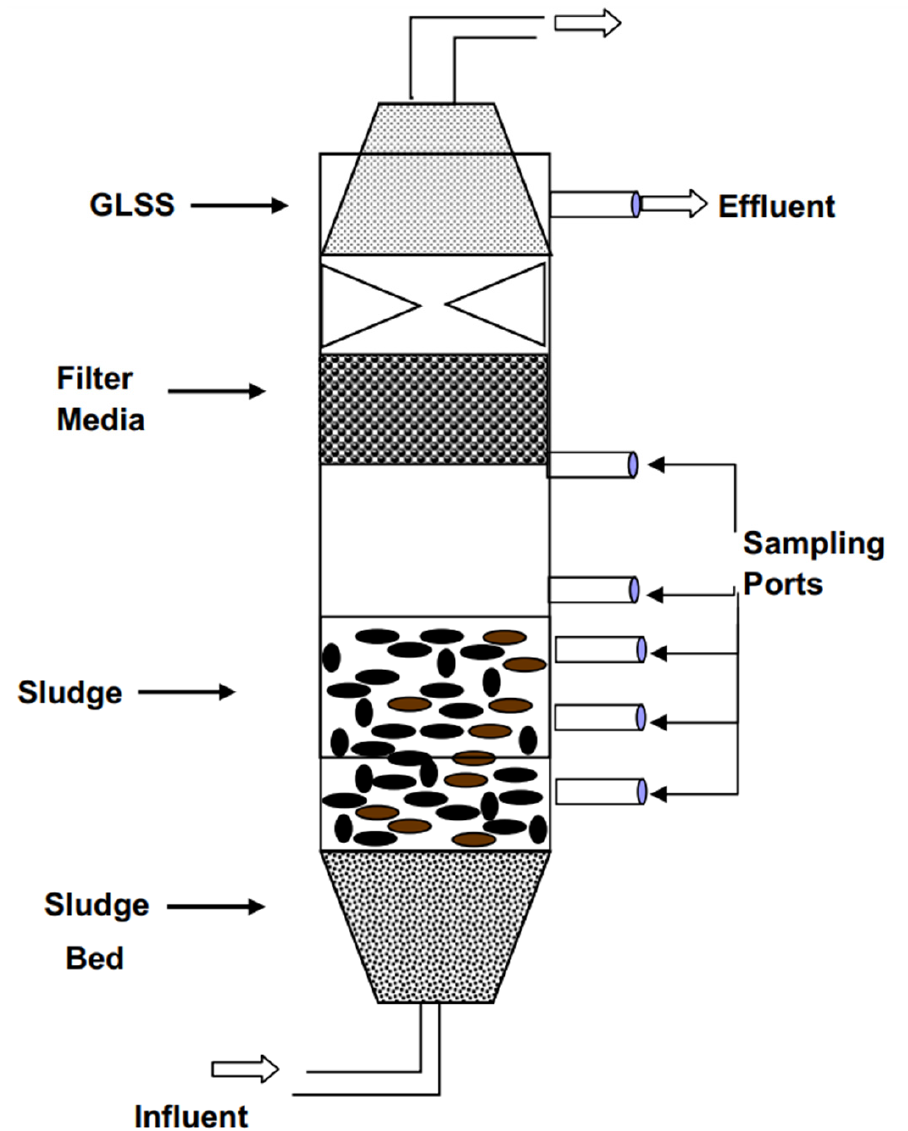
Figure 4. Schematic depiction of an anaerobic HRS. Reprinted from Ref. [116], Copyright (2013), with permission from Elsevier.